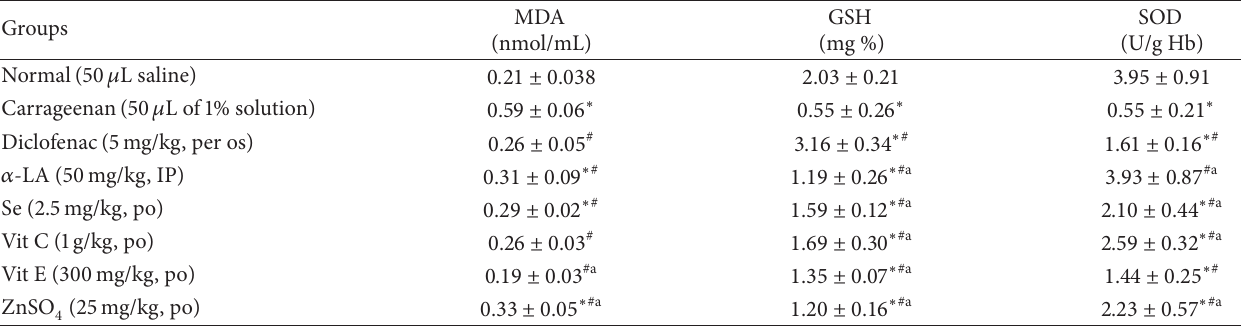
Table 3: Effects of diclofenac, 𝛼 -LA, selenite, Vit C, Vit E, or zinc on plasma levels of MDA, hemolysate GSH, and erythrocyte SOD activity in a rat carrageenan-induced paw edema model.